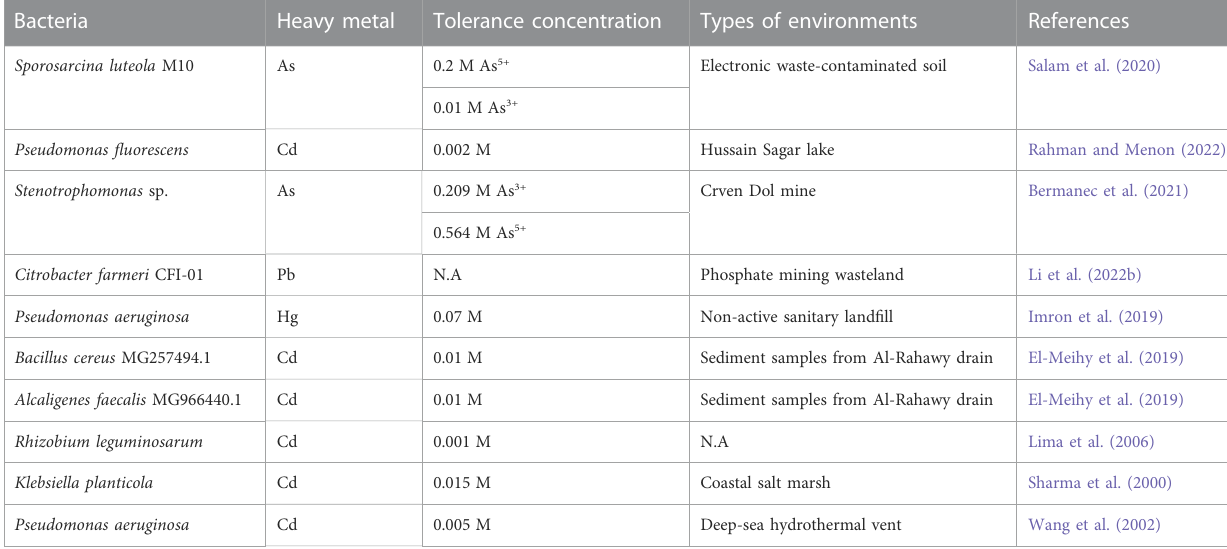
TABLE 2 Natural heavy metal-resistant